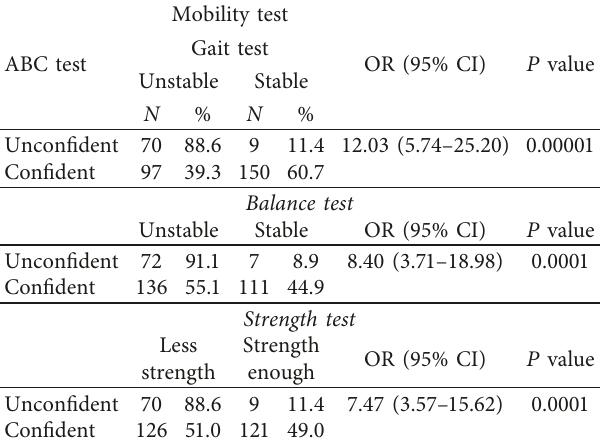
Table 4: Associations between the ABC test and the mobility test. Mobility ABC test